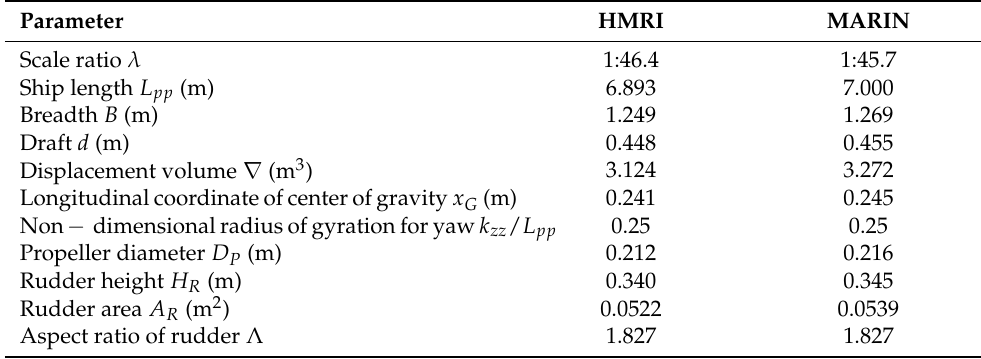
Figure 2. Geometry of the fully appended KVLCC2 ship model. Table 1. Principal particulars of KVLCC2 ship models with different scale